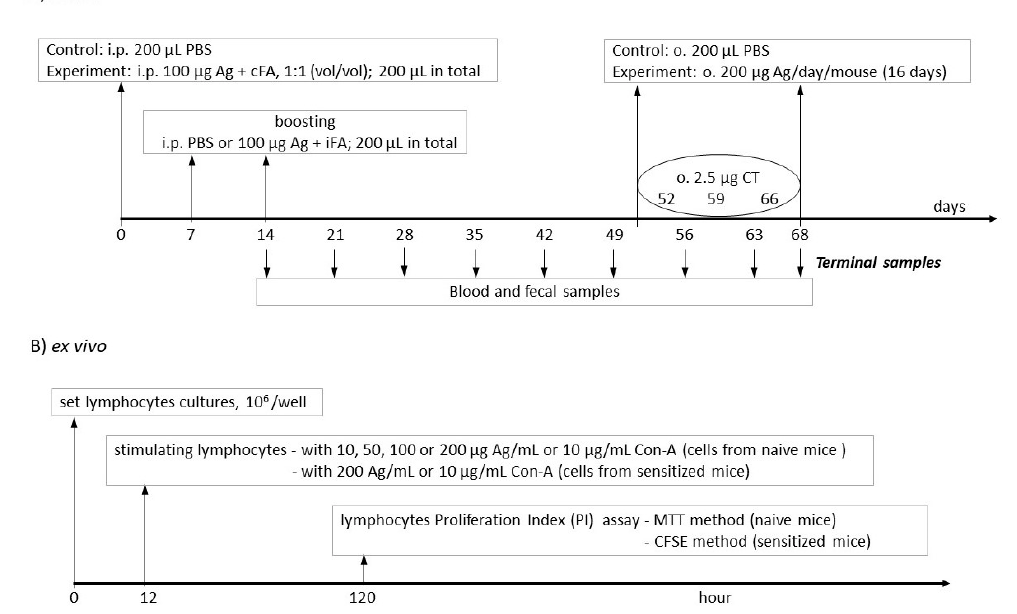
Figure 1. Scheme of experiments design ( A ) in vivo and ( B ) ex vivo. Used abbreviations: Ag—antigen; cFA—complete Freund adjuvant; iFA—incomplete Freund adjuvant; CT—cholera toxin.